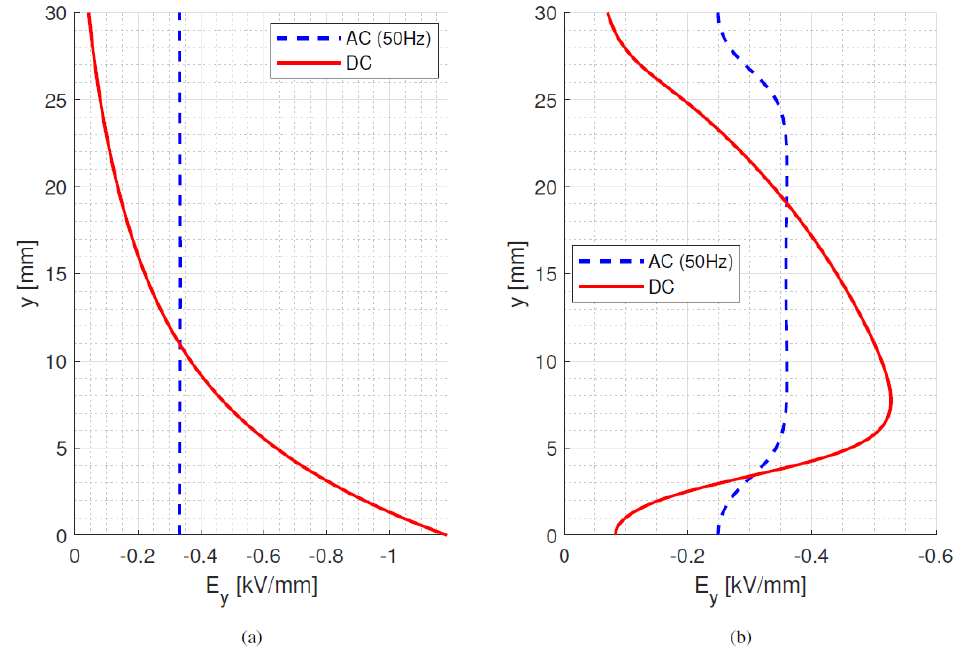
Figure 3. Bulk ( a ) and tangential surface ( b ) ac and dc steady-state fields at 10 kV with 40 °C temperature gradient, from 25 to 65 °C. Model parameter values from Table 1.